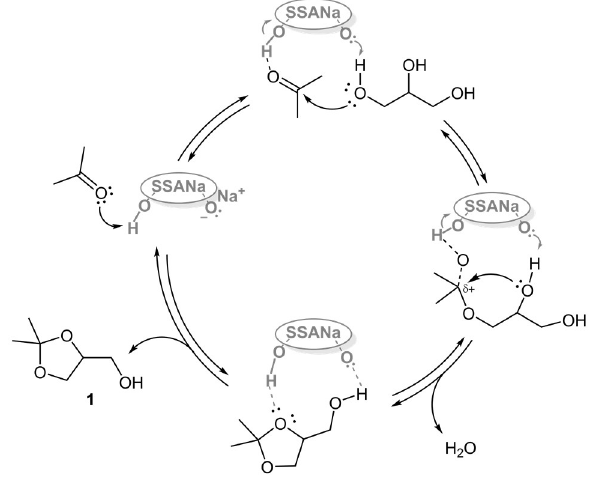
Figure 6. Plausible reaction mechanism.